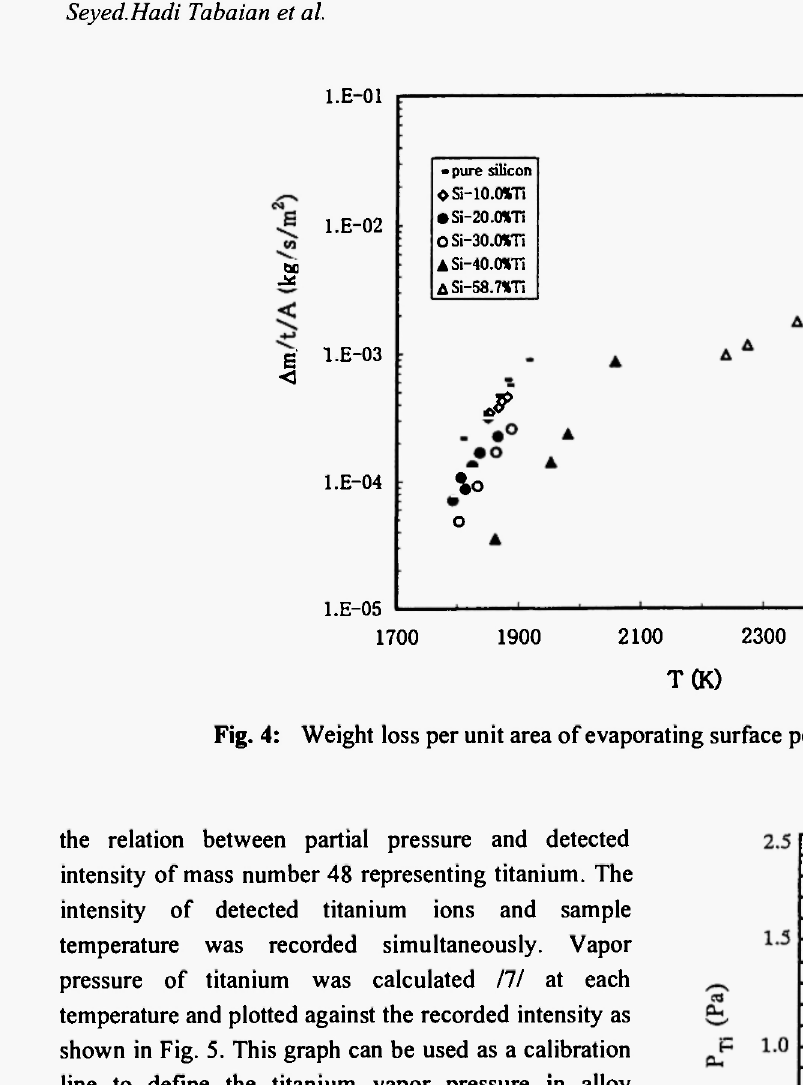
Fig. 4: Weight loss per unit area of evaporating surface per unit time during experiments.